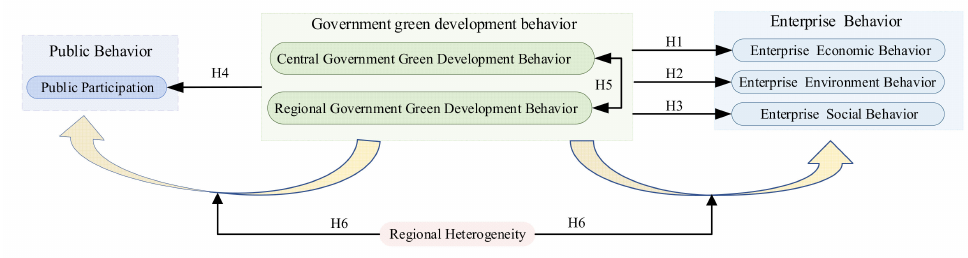
Figure 3. Hypothetical